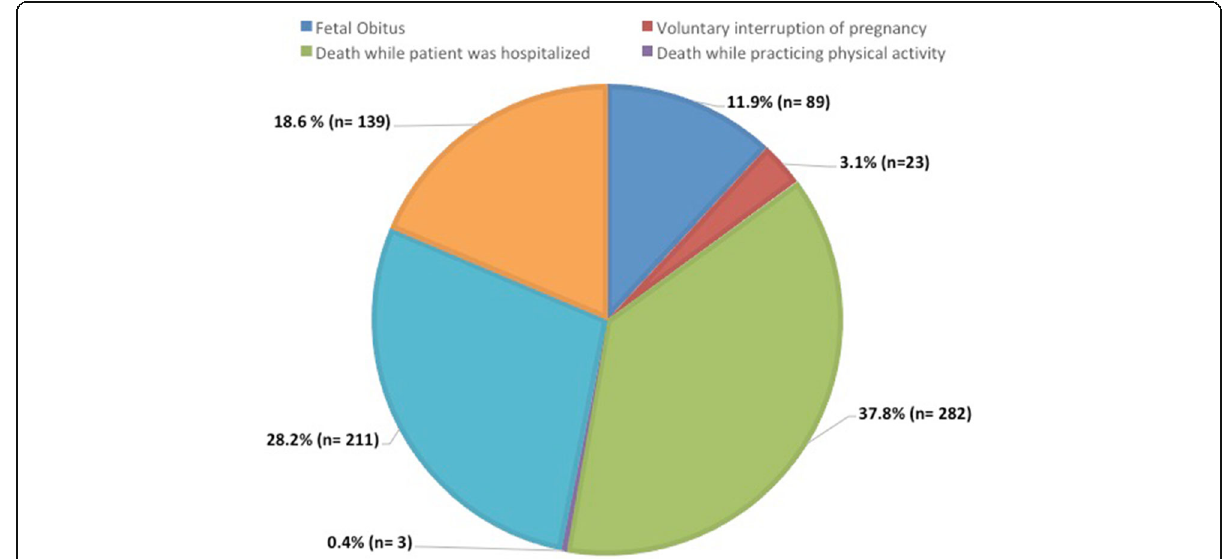
Fig. 2 Environmental circumstances regarding to the moment of